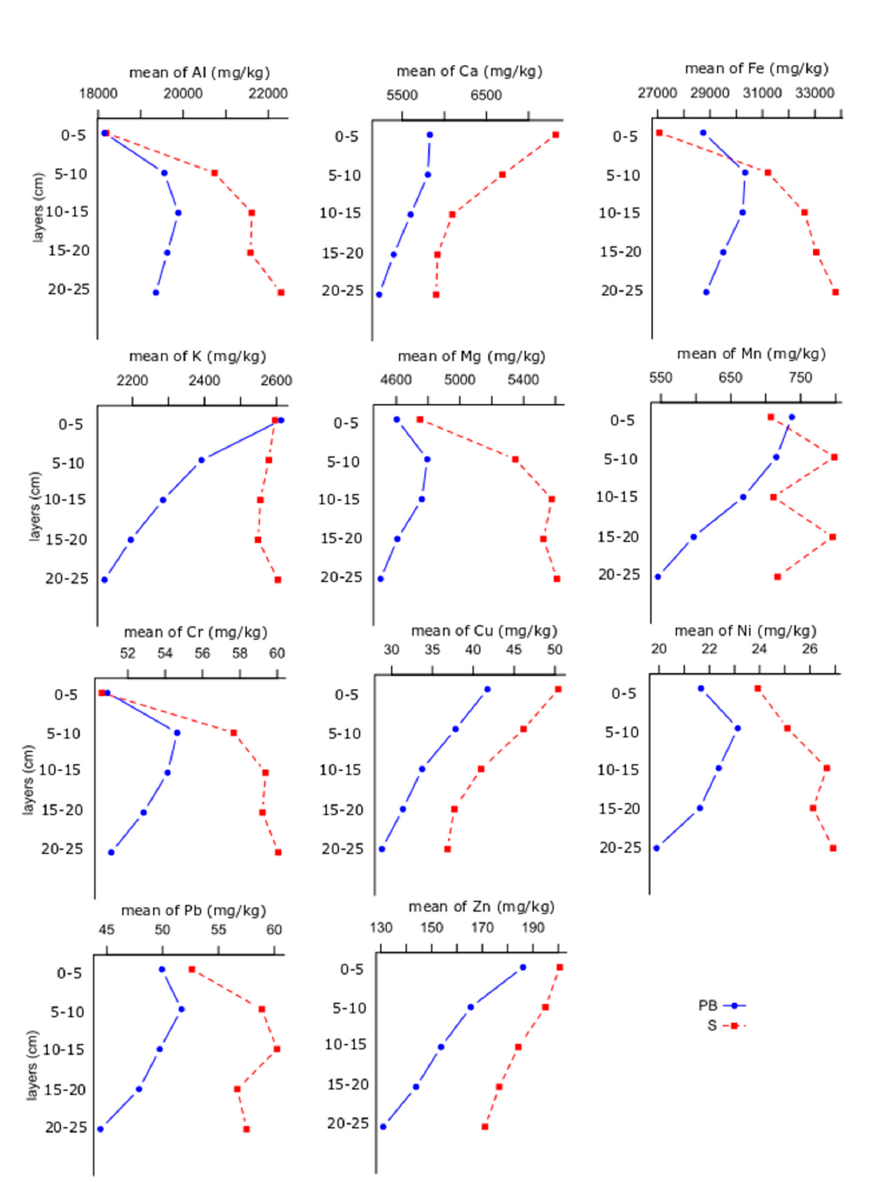
Figure 3. Interaction plot of the vertical distribution of metals (unit: mg / kg; PB: point bar—blue; S: swale—red).